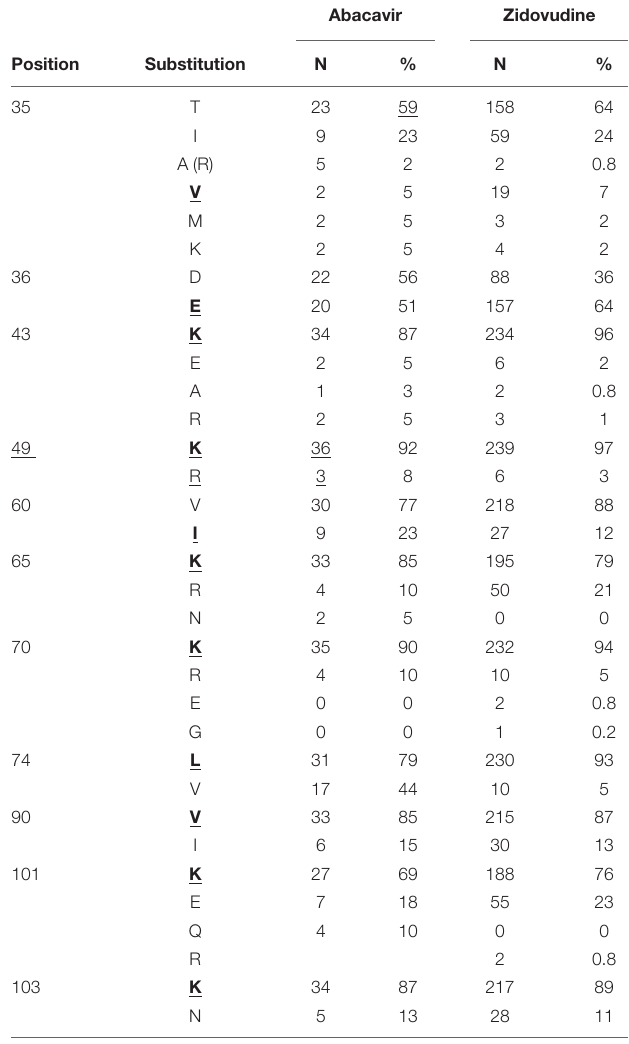
TABLE 2 | The substitutions appeared in the amino acid sequences of HIV RT of the samples, retrieved from patients that used nucleoside RT inhibitor abacavir or zidovudine in therapy